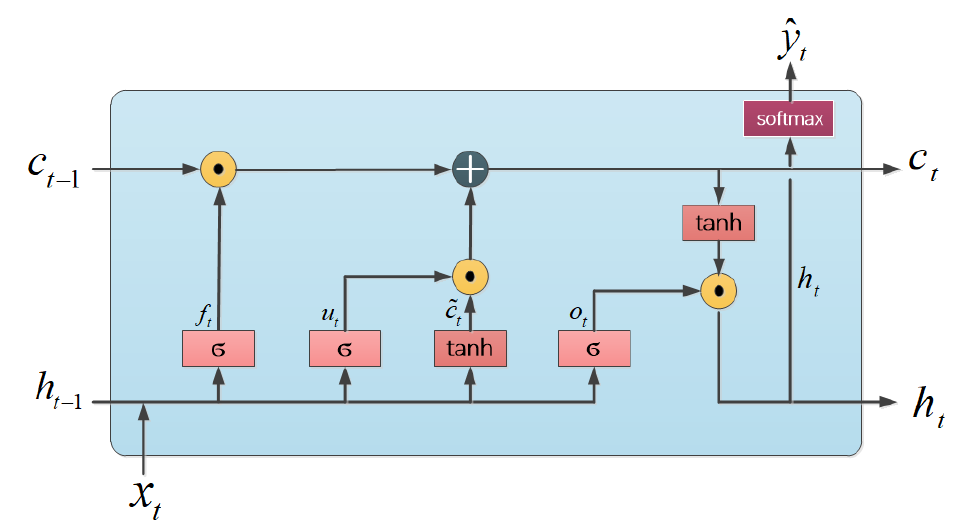
Figure 3. Illustration of each module of